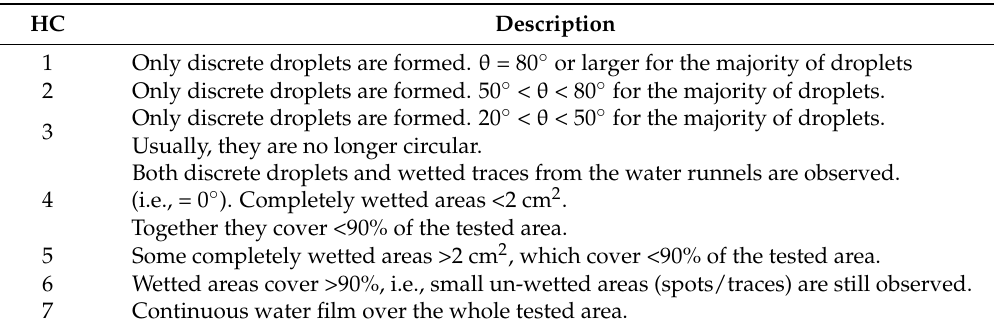
Table 1. Criteria for evaluation of HC.